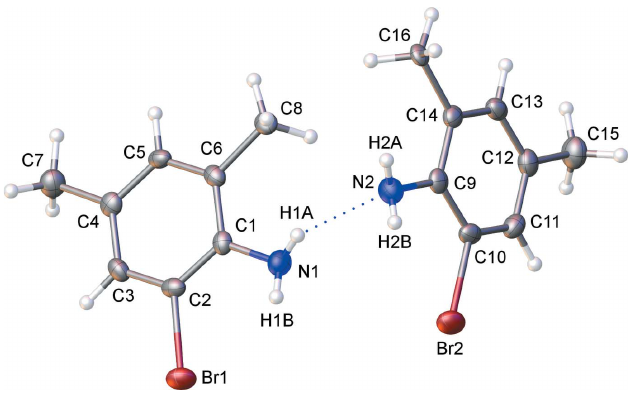
Figure 2 Displacement ellipsoid plot (50% probability) of the asymmetric unit of compound 2 . Hydrogen atoms are omitted for clarity.